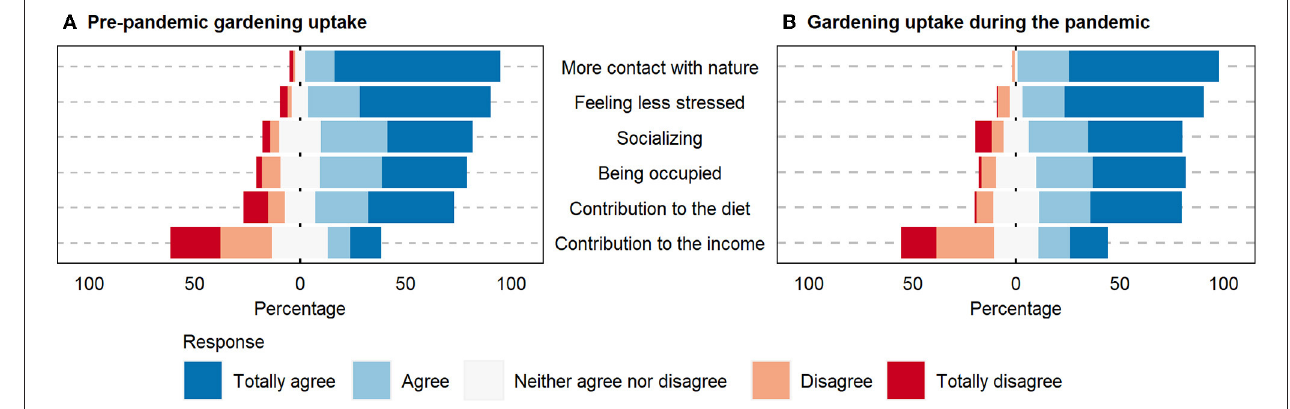
FIGURE 6 | Respondents’ perceptions of the benefits provided by urban gardening, differentiated according to the time of their gardening uptake. There were no significant differences in the perception of benefits between gardeners who started pre- or during the pandemic. (A) Pre-pandemic gardening uptake. (B) Gardening uptake during the